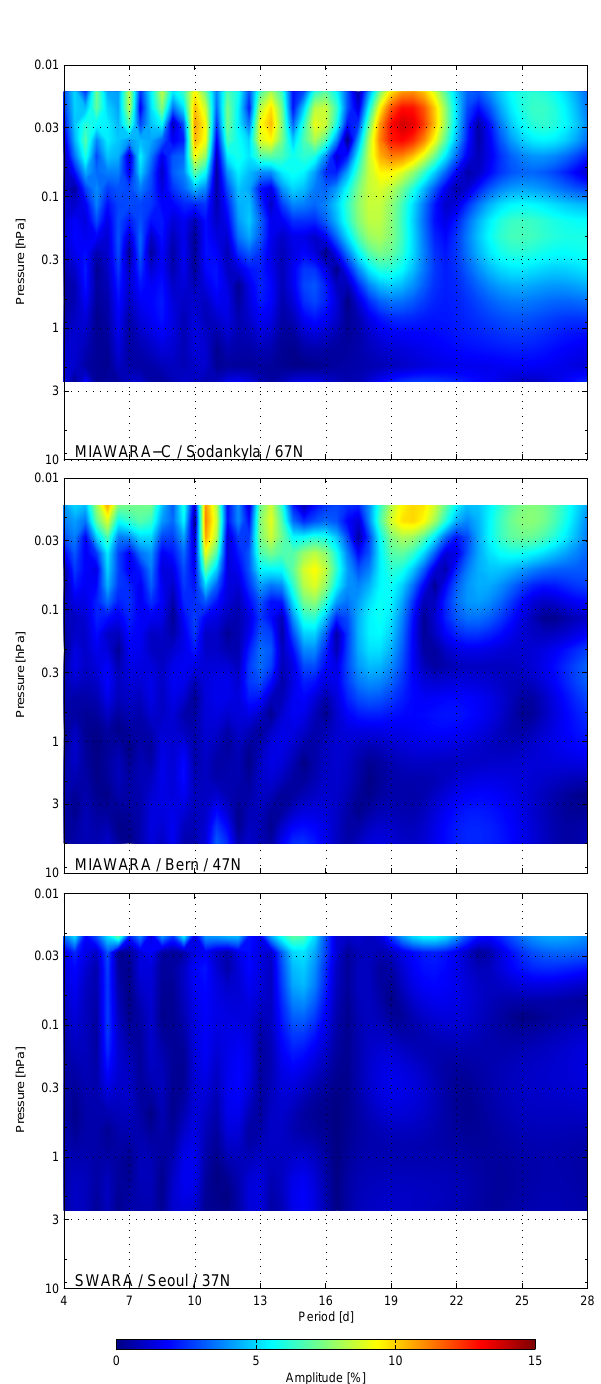
Figure 2. Analogous to Fig. 1, but showing the results as relative wave amplitudes. The relative amplitudes were calculated by dividing the absolute wave amplitudes from Fig. 1 by the average water vapor VMR within the considered time period at each pressure level.